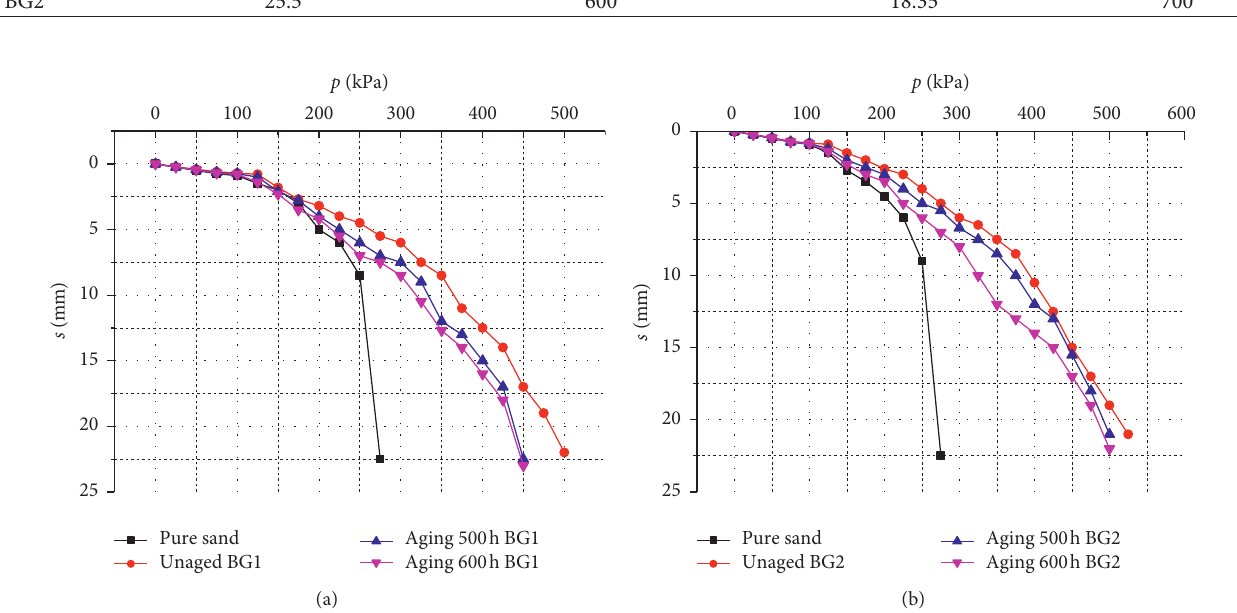
Table 5: The tensile strength of geogrid before and after aging. Tensile strength of geogrid before aging Radiation intensity (W/ Tensile strength of geogrid after aging of Geogrid (kN/m) m 2 ) 700h 15.8